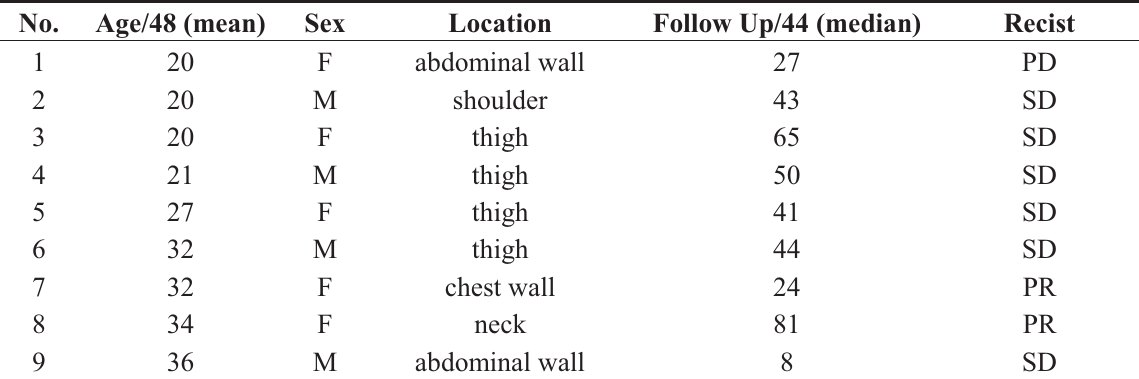
Table 1. Clinical data of patients with